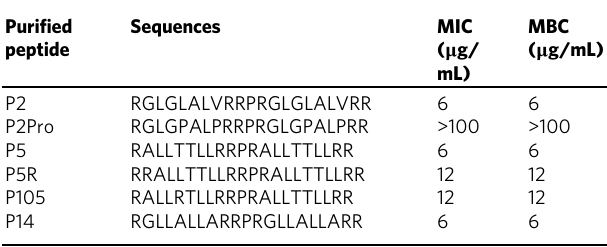
Table 1 MIC and MBC values of selected peptides puri fi ed by HPLC grade on E . coli O157 Puri fi ed